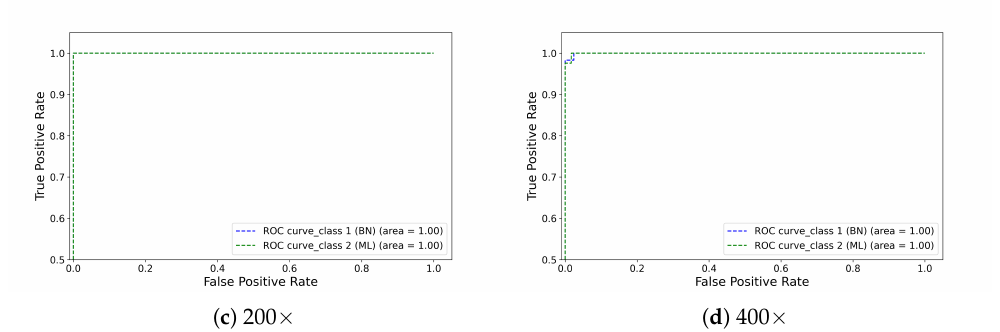
Figure 5. Illustration of the ROC curve obtained through the proposed model on the test set. Note that ( a – d ) refer to the 40 × , 100 × , 200 × , and 400 × magnifications, respectively.